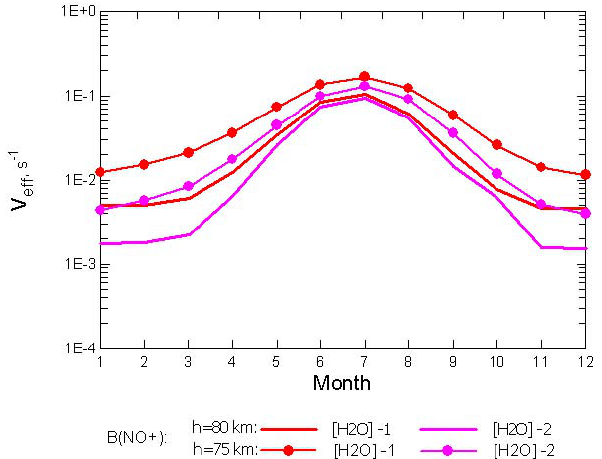
Fig. 5a. Electron density profiles for 16 June 2004 at 12:00UT. The black line corresponds to the electron density profile measured by the EISCAT radar; red, violet and blue lines correspond to the elec- tron density profiles calculated for the H 2 O-1, H 2 O-2 and H 2 O-3 profiles,